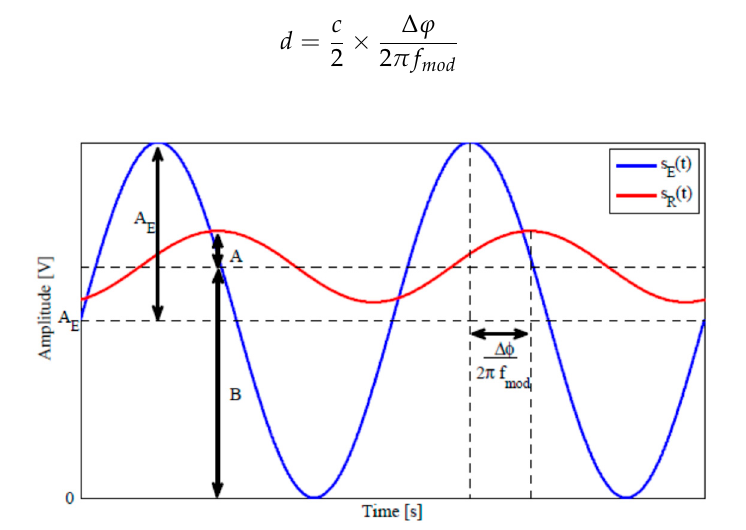
Figure 6. Emitted signal (blue) and received signal (red).